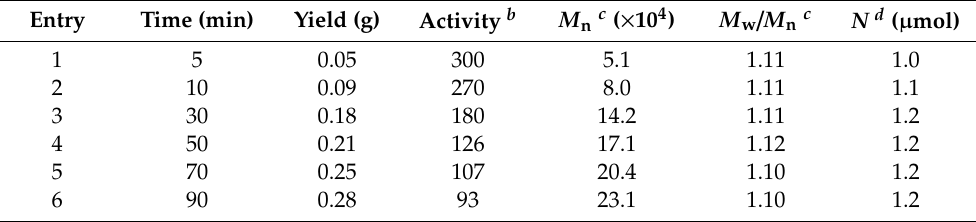
Table 4. Living copolymerization of propylene and 1-decene with 2 -MMAO. a